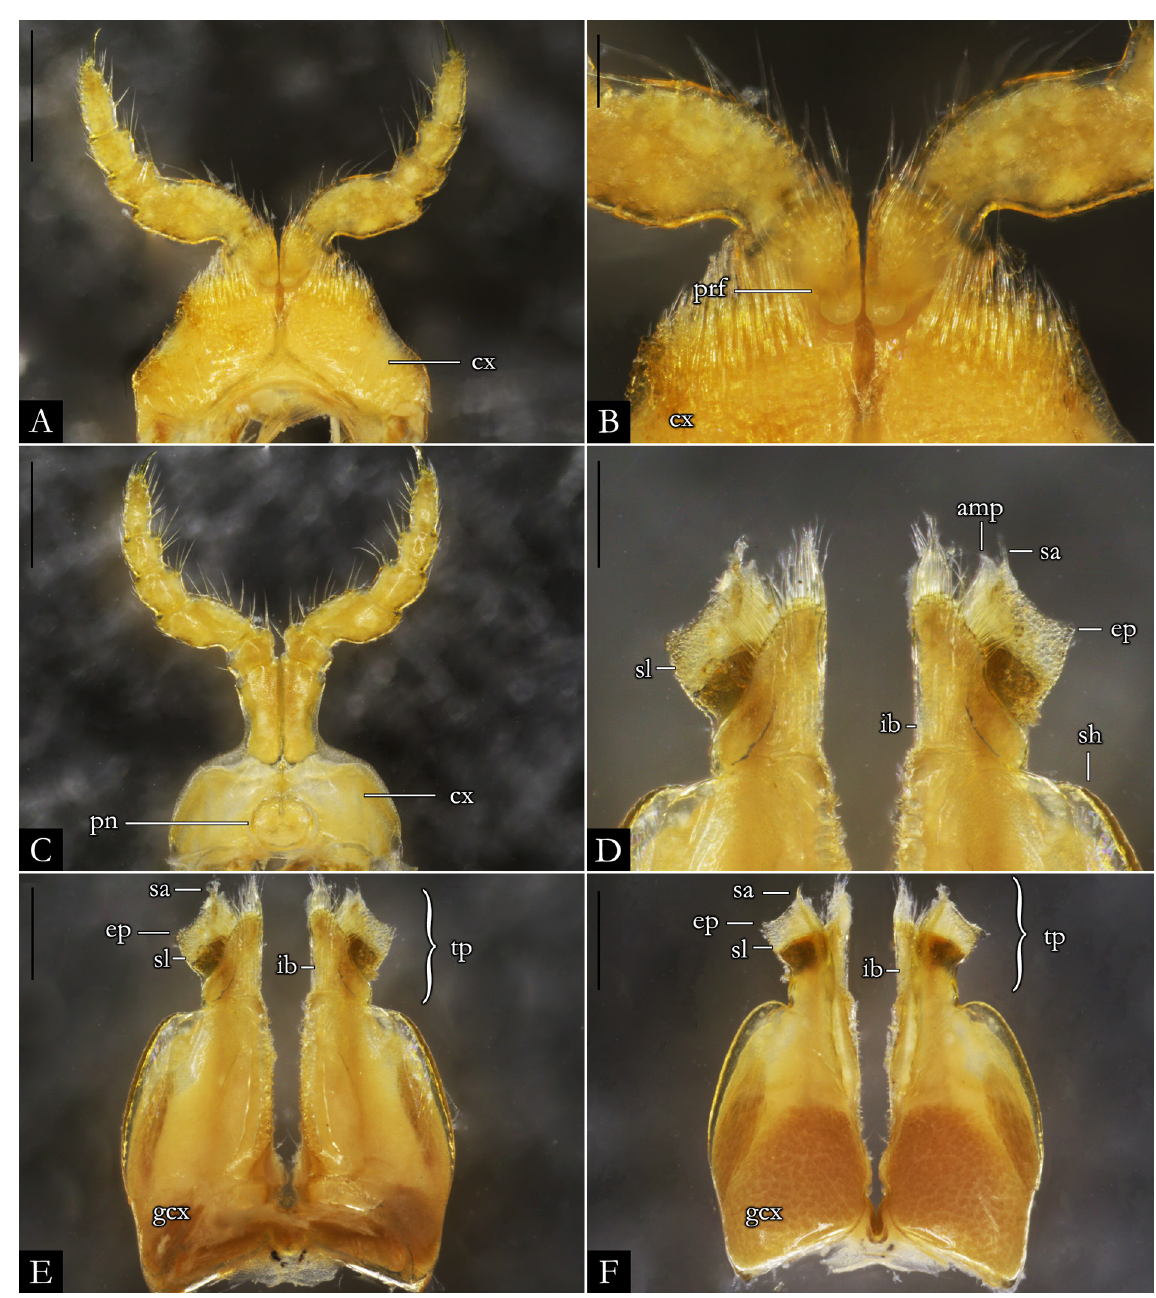
Fig. 55. Pseudonannolene buhrnheimi Schubart, 1960, ♂ (IBSP 2399). A . First leg-pair. B . Detail of prefemur. C . Second leg-pair. D . Detail of telopodites, in anal view. E . Gonopods, in anal view. F . Gonopods, in oral view. Abbreviations: see Material and methods. Scale bars: A, C = 0.5 mm; B, D–F = 0.2